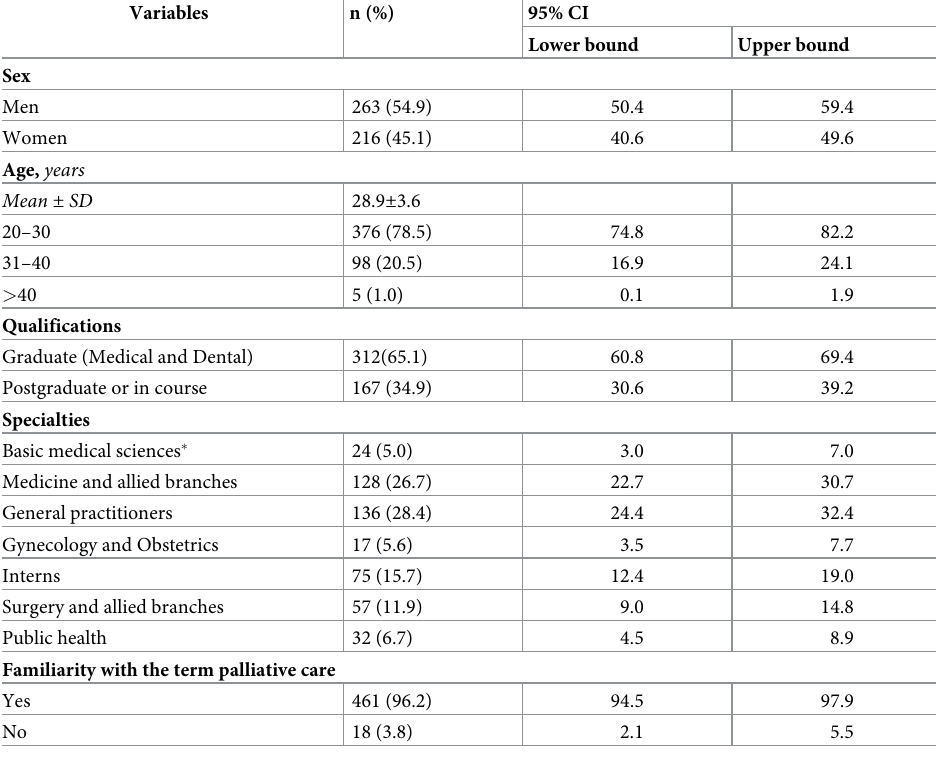
Table 1. Baseline characteristics of the respondents (n =